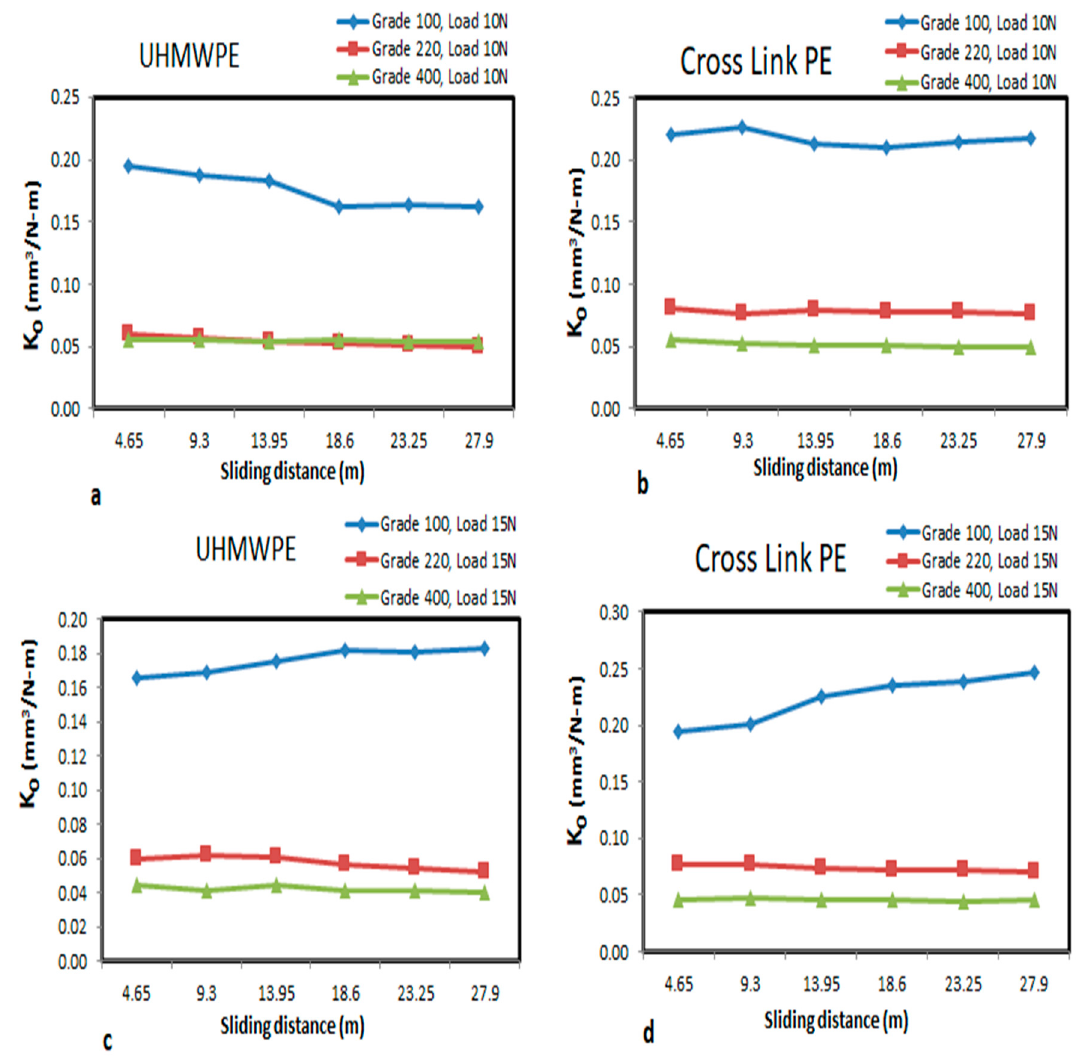
Figure 4. ( a – d ). Specific wear rate v/s sliding distance for UHMWPE and Cross Link for 10 N and 15 N loads with different grades of abrasive for wear test